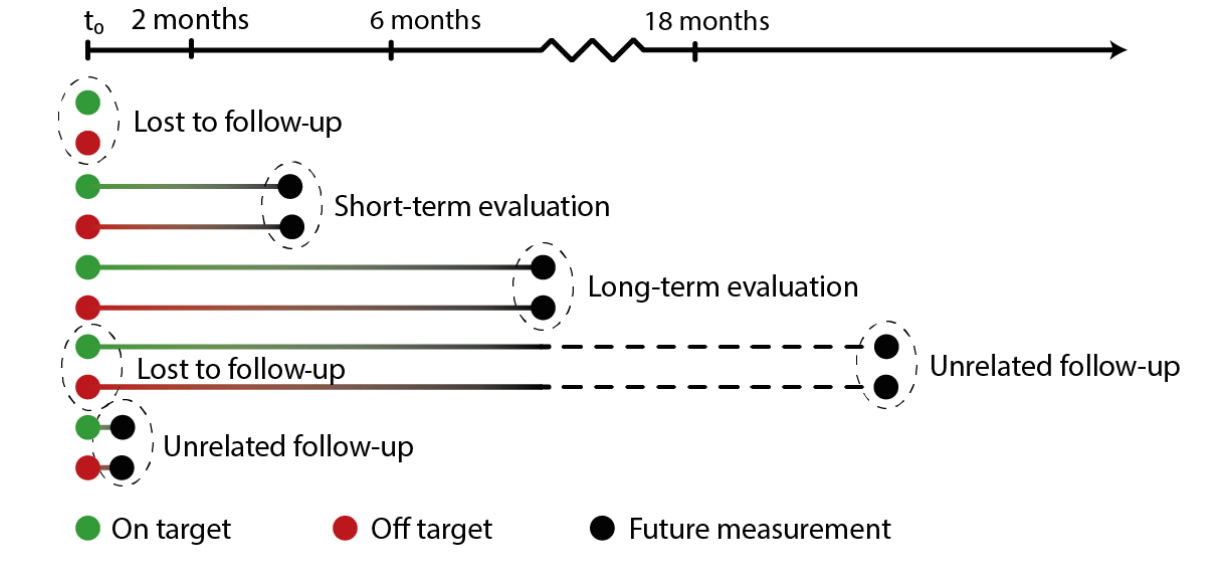
Figure 1. Visualization of possible follow-up